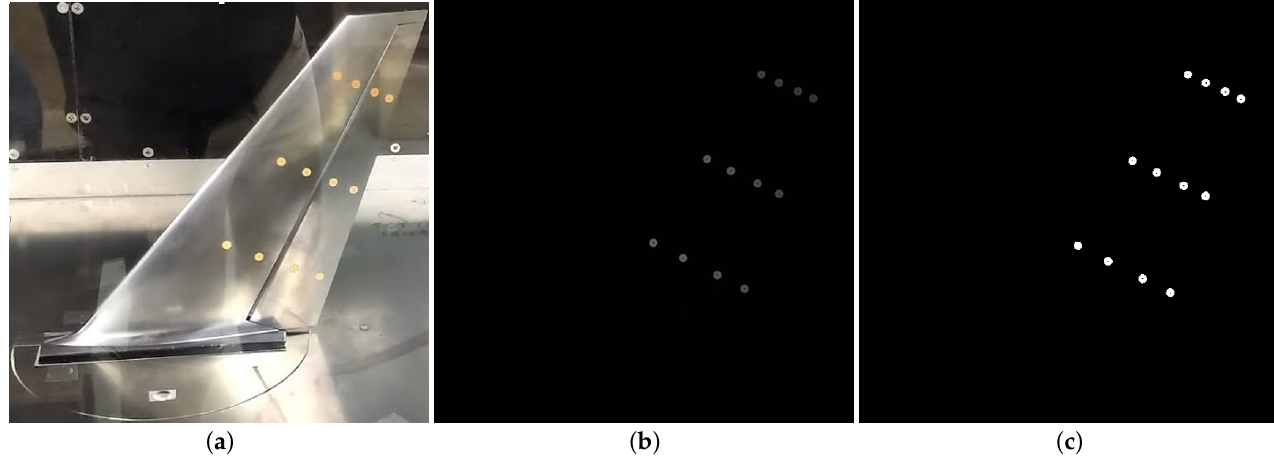
Figure 3. Detection of the model surface markers using optical measurement. ( a ) Markers attached to the model. ( b ) Image data shot by the camera. ( c ) Markers detected from image